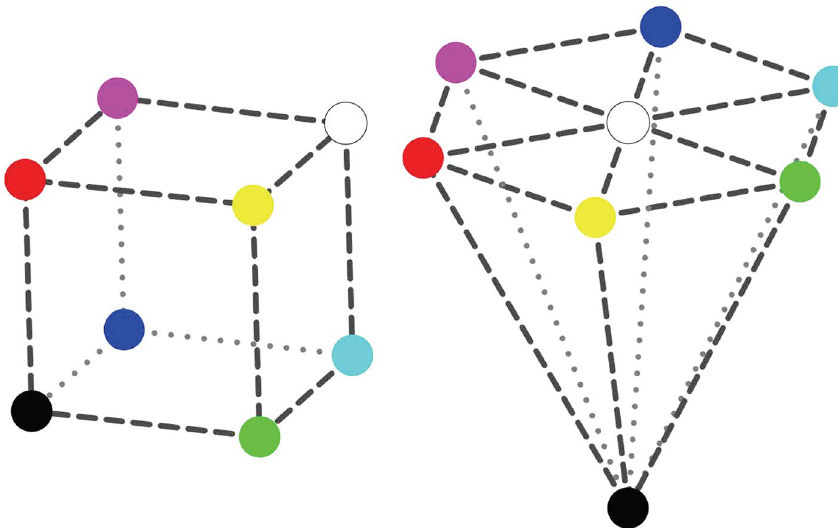
Fig. 1 A visual representation of RGB and HSV (Hexcone model) color spaces. White color is black outlined to contrast it better against the